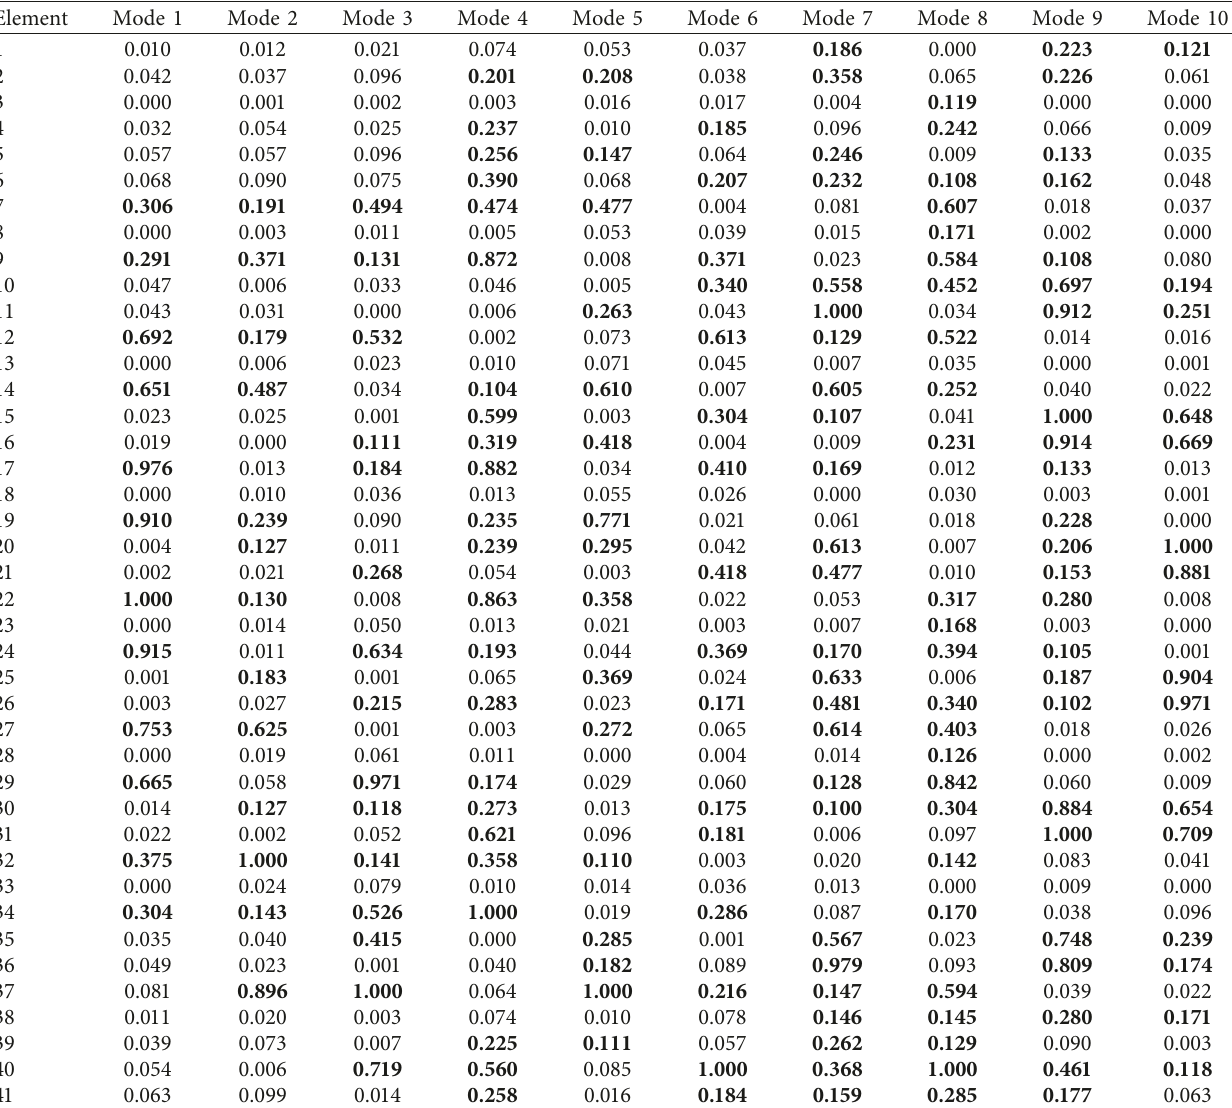
Table 2: Normalized elemental MSE of the intact structure for the first ten